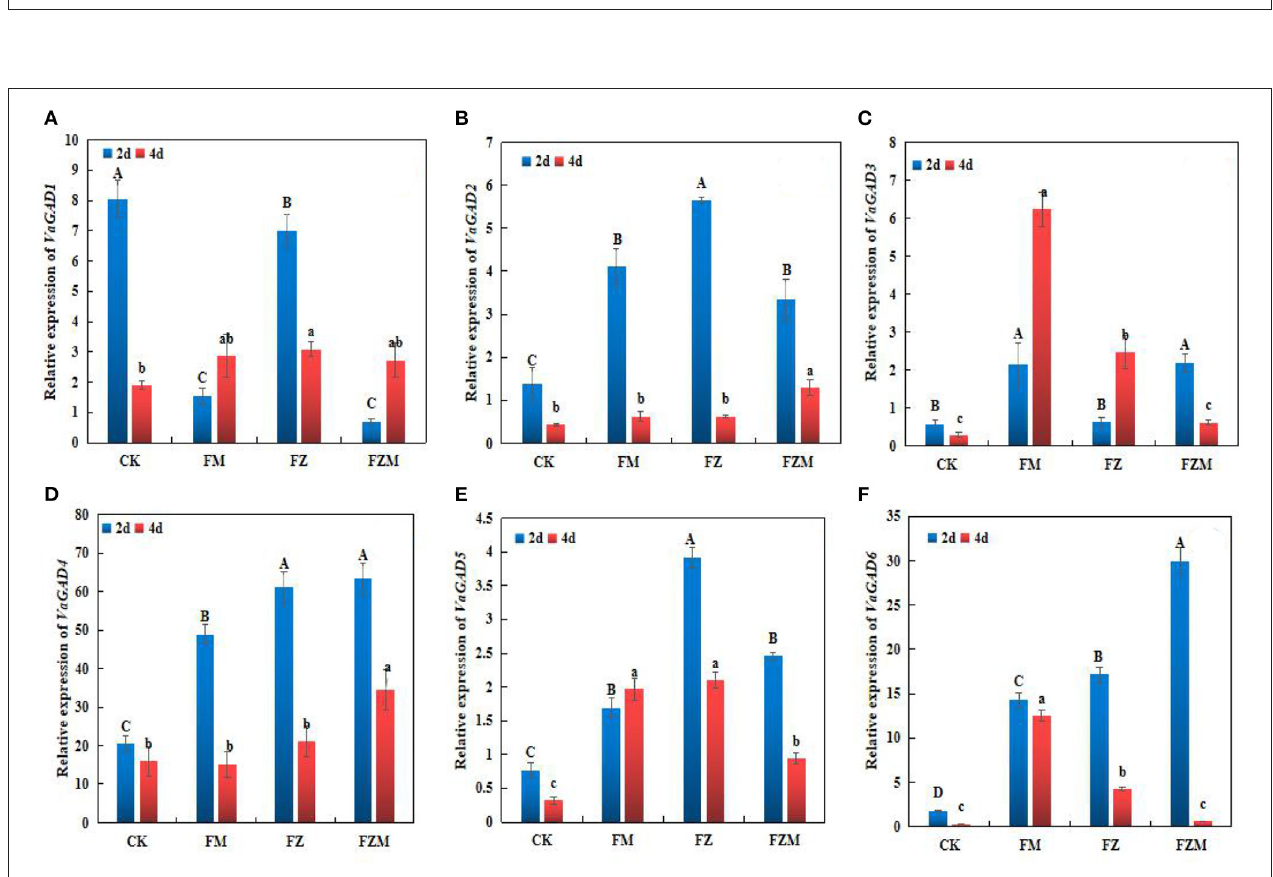
FIGURE 6 | (A) VaGAD1 , (B) VaGAD2 , (C) VaGAD3 , (D) VaGAD4 , (E) VaGAD5 , and (F) VaGAD6 relative expression trends in germinating adzuki beans. The upper and lower case letters in the figure reflect significant differences between treatments at 2 and 4 d of germination ( p < 0.05). CK: Control treatment (31 ◦ C for 4 d); FM: 2 mg/ml MSG treatment; FZ: 15h vacuum treatment; FZM: 15h vacuum + 2 mg/ml MSG treatment (sprayed every 1h).